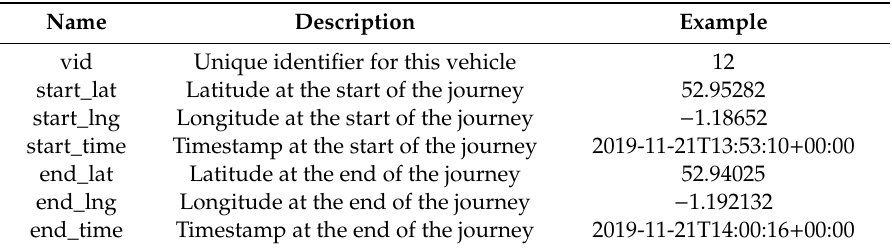
Table 1. Example data received for each vehicle